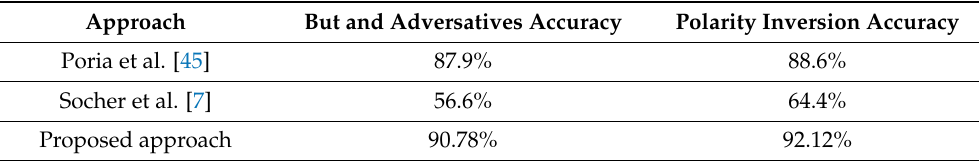
Table 9. The state-of-the-art comparison with the proposed approach of text and multiple emoji patterns of ‘but’ and polarity inversion sentiment sentences using the SVM classifier.